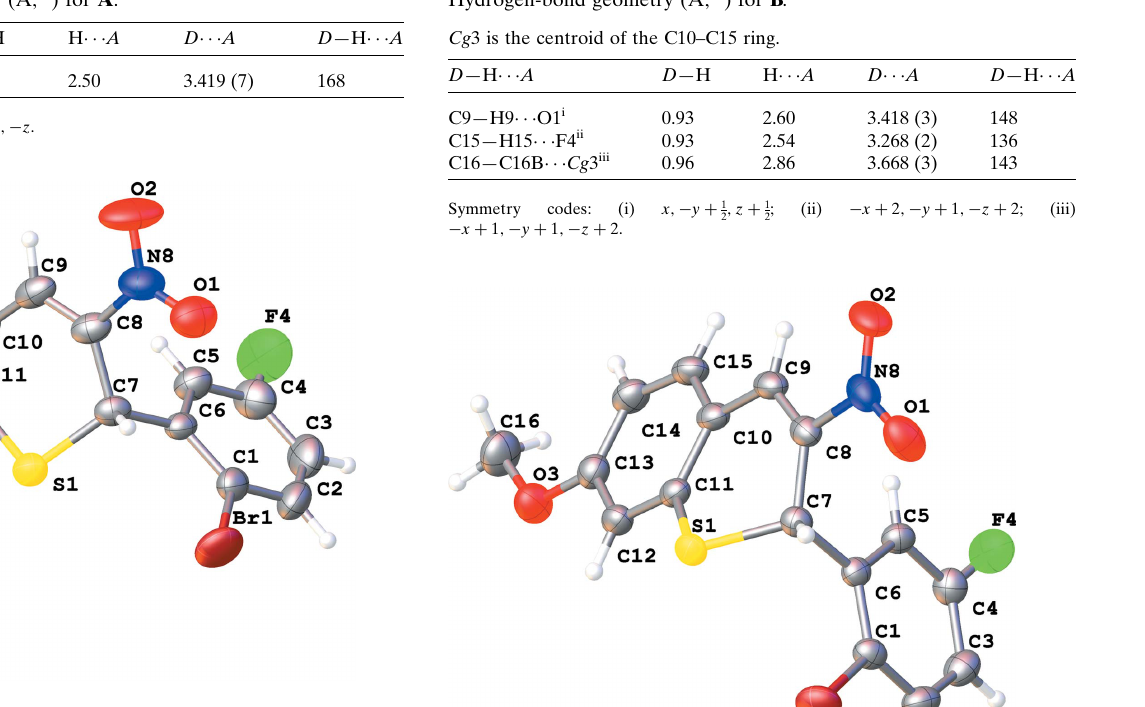
Table 1 Hydrogen-bond geometry (A˚ , (cid:3) ) for A .